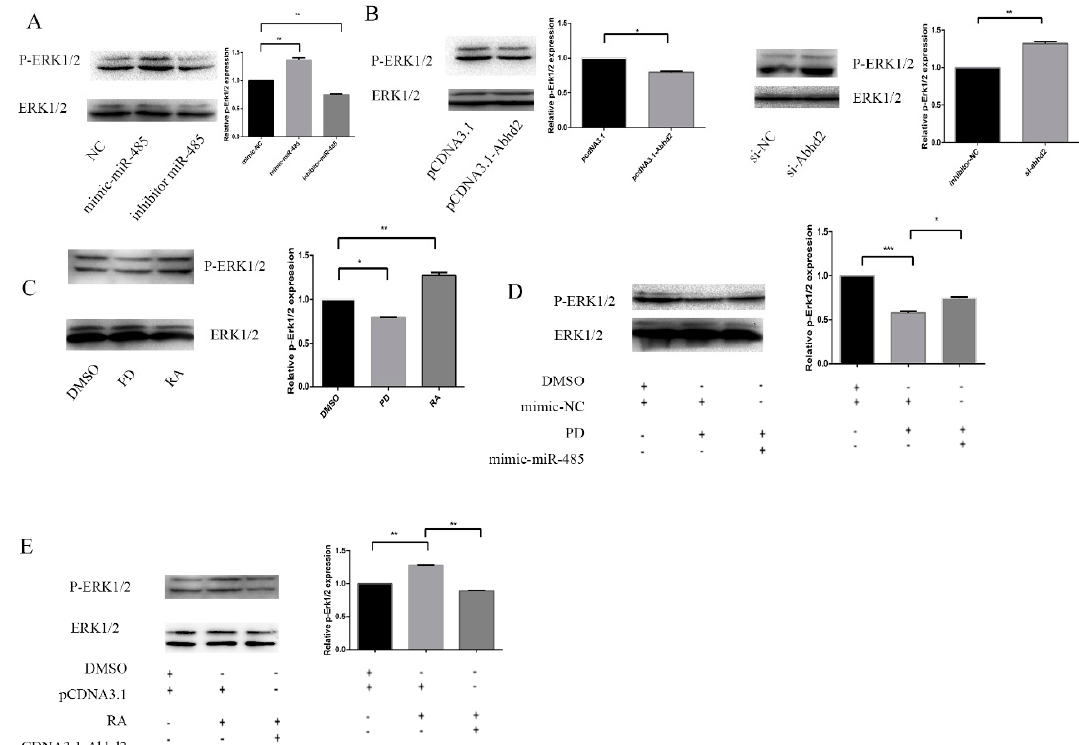
Figure 4. RA regulates Erk1 / 2 phosphorylation through miR-485 and Abhd2 in F9 ECs ( A ) Western Blot analysis with statistical analysis of phosphorylation of ERK1 / 2 that were modulated by miR-485. F9 ECs were transfected with mimic-NC, mimic-miR-485 and inhibitor of miR-485 for 36 h. phosphorylation of ERK1 / 2 level was analyzed by Western Blot. Total ERK1 / 2 was used to normalize template levels. Data are presented as the mean ± SD of three independent experiments (* p < 0.05; ** p < 0.01; *** p < 0.001). ( B ) Western Blot analysis with statistical analysis of phosphorylation of ERK1 / 2 that were modulated by Abhd2. F9 ECs were transfected with pCDNA3.1, pCDNA3.1-Abhd2, si-NC and si-Abhd2 for 36 h, Total ERK1 / 2 was used to normalize template levels. ( C ) Western Blot analysis with statistical analysis of phosphorylation of ERK1 / 2 that were altered by RA or PD. F9 ECs were treated with 2 µ M PD, RA or DMSO respectively for 36 h. Total ERK1 / 2 was used to normalize template levels. ( D , E ) Western Blot analysis with statistical analysis of phosphorylation of ERK1 / 2 with di ff erent treatment. ( D ) F9 ECs were transfected with mimic-NC or mimic-miR-485, 6 h after transfection, the cells were treated with 2 µ M PD or DMSO. phosphorylation of ERK1 / 2 level was analyzed by Western Blot. Total ERK1 / 2 was used to normalize template levels. ( E ) F9 ECs were transfected with pCDNA3.1, pCDNA3.1-Abhd2, 6 h after transfection, the cells were treated with 2 µ M RA or DMSO. Total ERK1 / 2 was used to normalize template